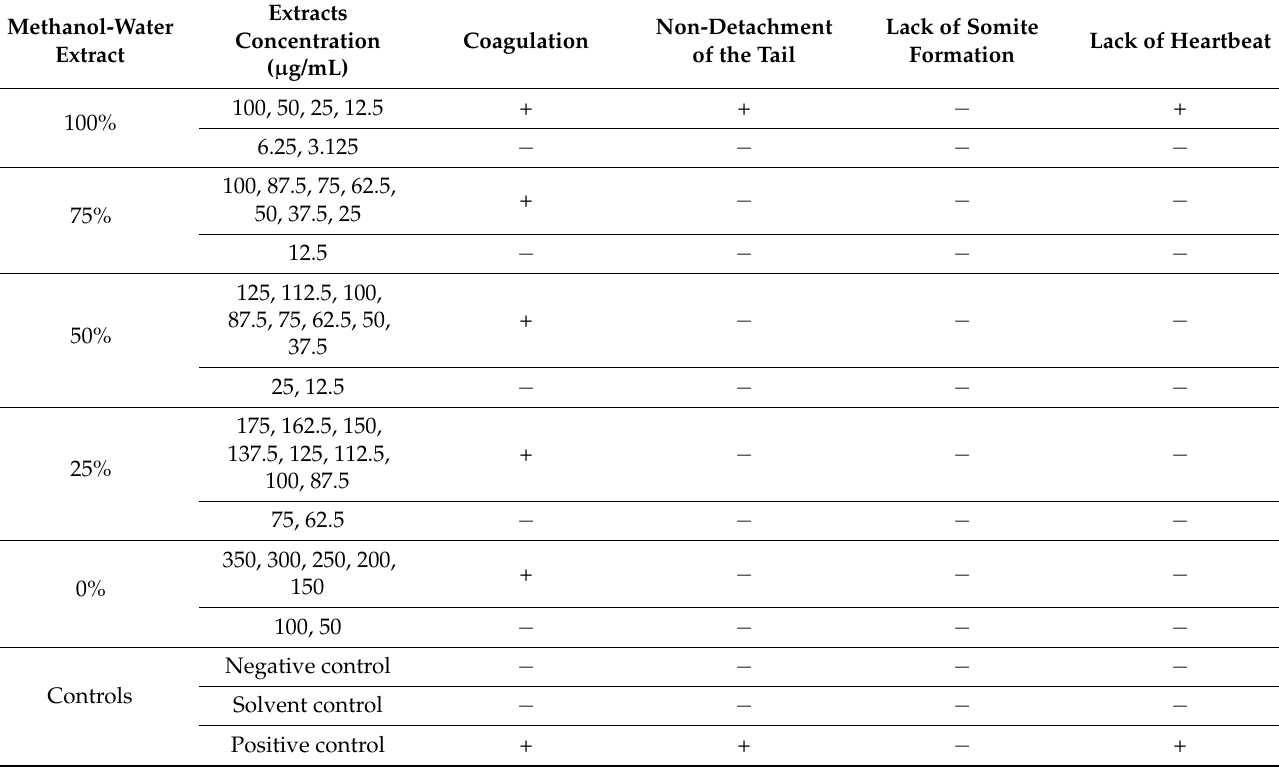
Table 3. Morphological defects related to the mortality of zebrafish embryos exposed to different extracts of P. malayana at 24 to 96 hpf along with the solvent control (0.1% dimethyl sulfoxide in E3 medium), positive control (4 mg/L of 3,4-dichloroaniline in E3 medium), and negative control (E3 medium) groups.